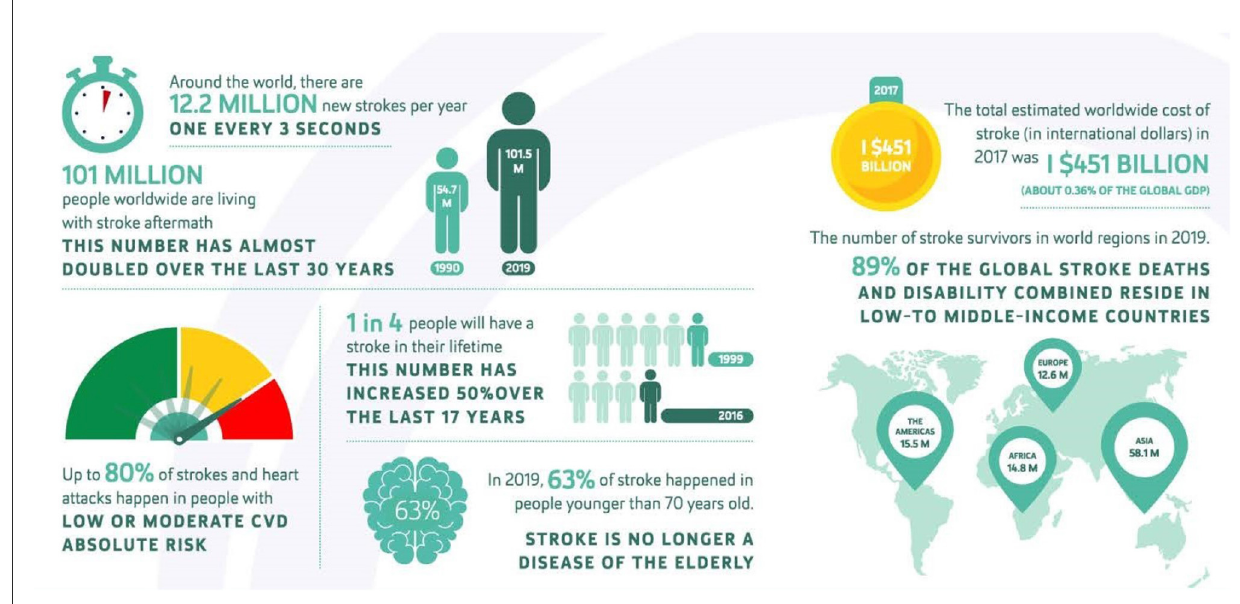
FIGURE1 Stroke infographic from World Stroke Organization (WSO): global stroke fact sheet 2022 (Feigin et al.,